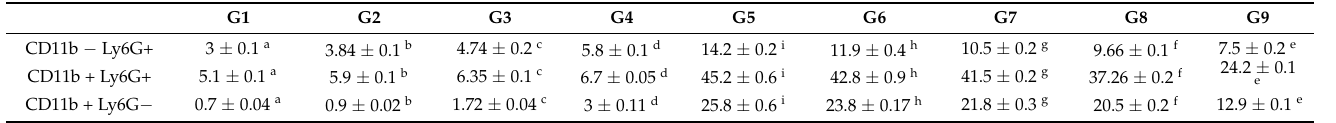
Table 2. The influence of L. plantarum , L. casei , S. platensis and in their combination on myeloid cells in blood of albino